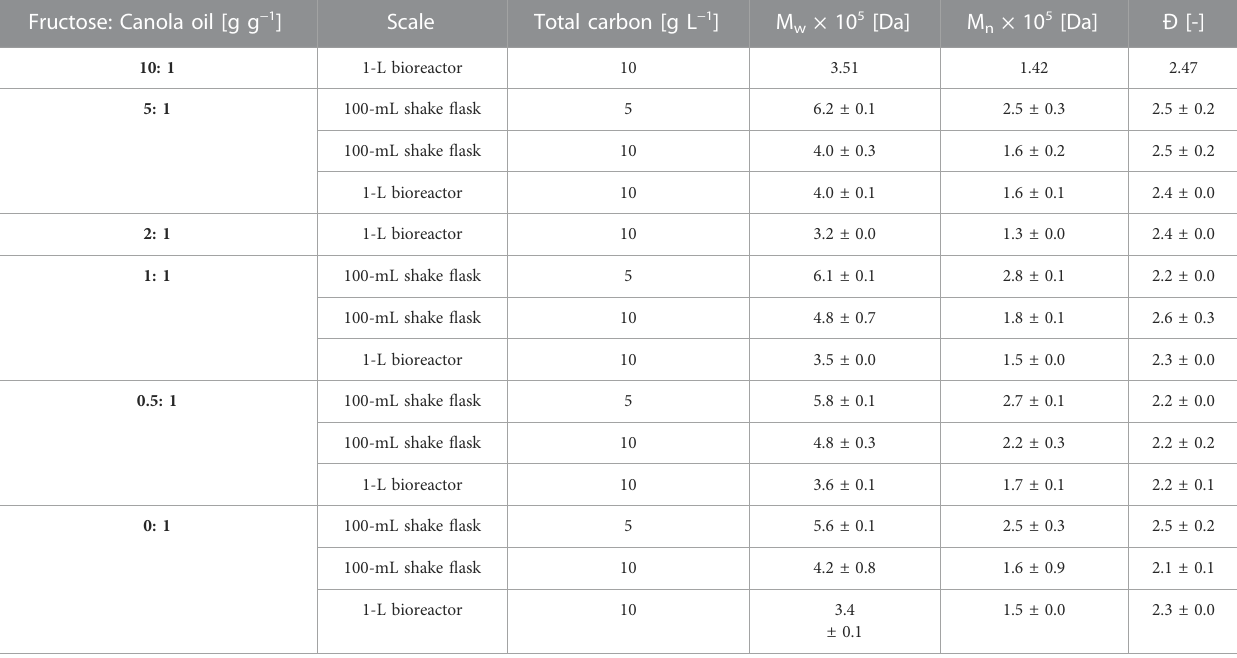
TABLE 2 Molecular weight characterization of samples after 72 h of 100-mL shake fl ask and 1-L bioreactor cultivations with R. eutropha Re2058/pCB113 using mixtures of fructose and canola oil and urea as nitrogen source with an applied C/N ratio of 22 g g-1. Mw = weight-average molecular weight, Mn = number- average molecular weight, Đ = polydispersity index. Measurements represent means from duplicate measurements. ± are indicating minimum and maximum values. Fructose: Canola oil [g g − 1